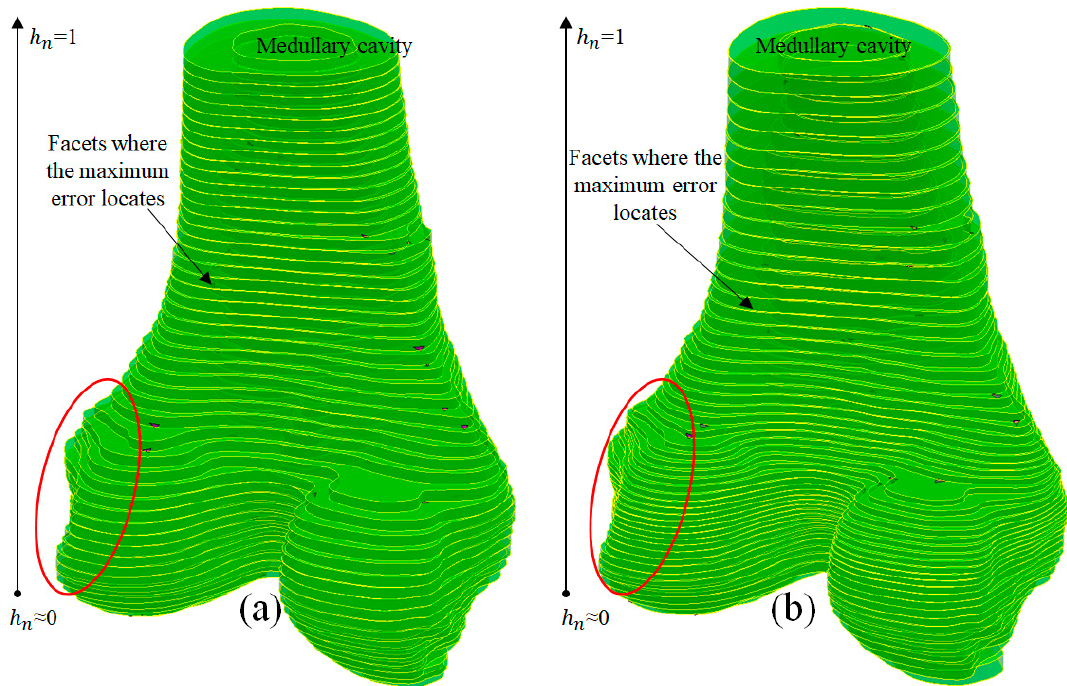
Figure 10. Virtual printing using Digital Twins considering manufacturing error where ( a ) is regarding uniform slicing; ( b ) is regarding adaptive